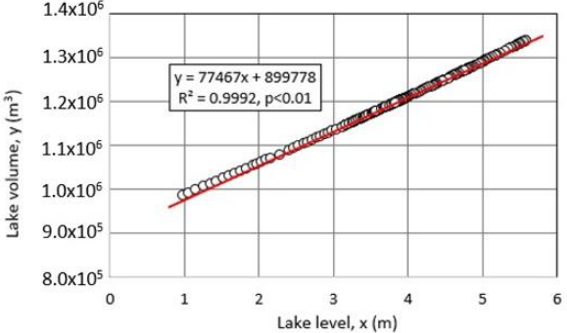
Figure 15. Relationship between the daily mean lake level and lake volume acquired by the 2020 – 2021